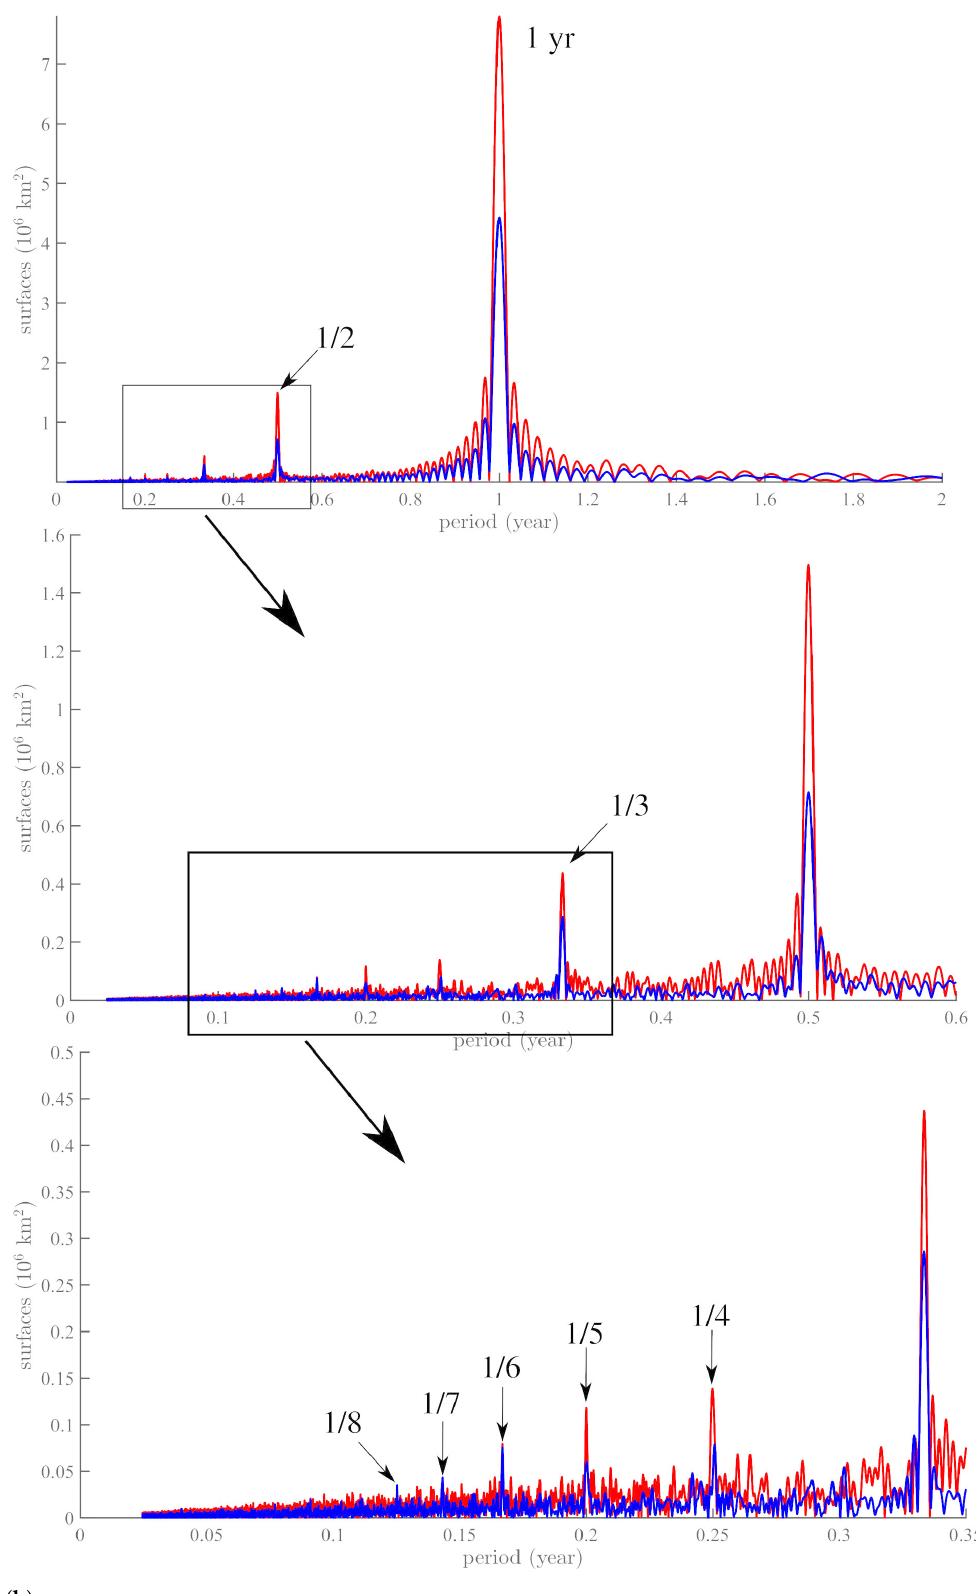
Figure 1. Temporal evolution of SHSI (red) and NHSI (blue): ( a ) raw southern hemisphere (SHSI, red) and northern hemisphere (NHSI, blue) sea-ice data and ( b ) Fourier spectra of the SHSI (red) and NHSI (blue) series in Figure